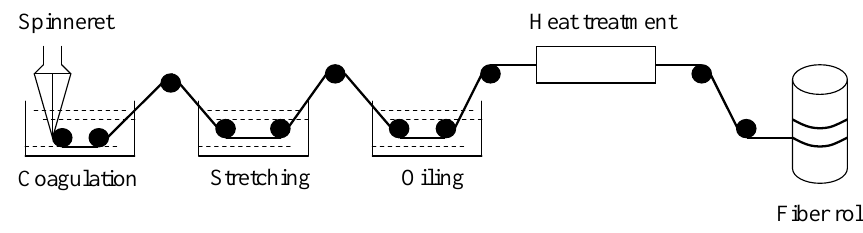
Figure 1. The technological process of carbon fiber